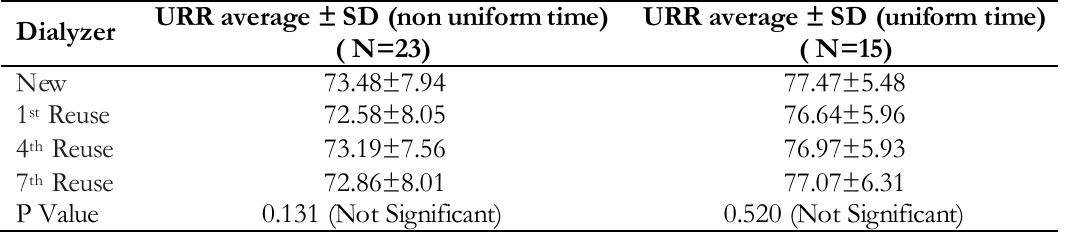
Table IV. Delivered dialysis dose of Kt/V from new and Reuse Dialyzer